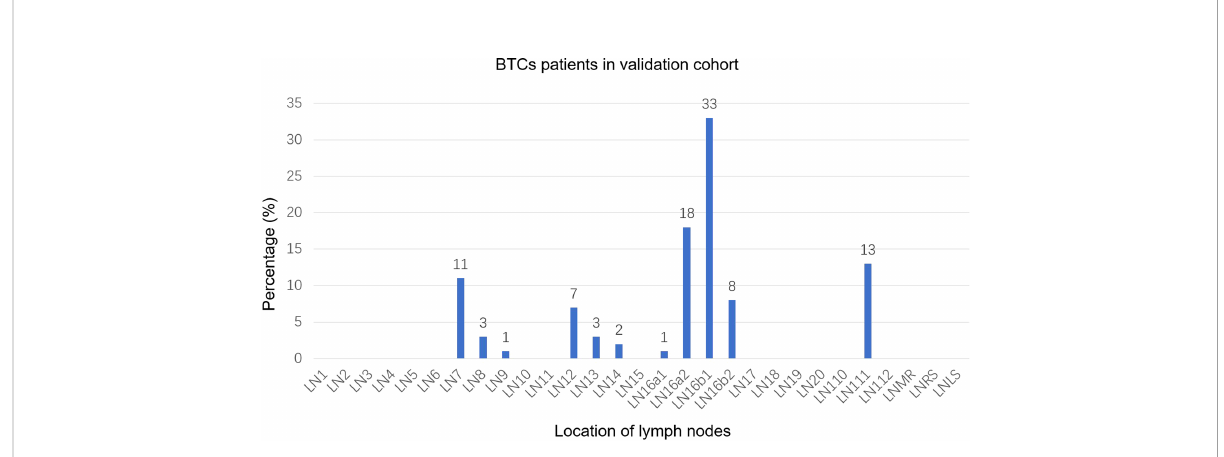
FIGURE 3 Distribution bar plot of positive lymph nodes in the validation cohort. BTCs, biliary tract cancer; LN, lymph node; LNMR, mediastinal lymph node; LNRS, right supraclavicular lymph node; LNLS, left supraclavicular lymph